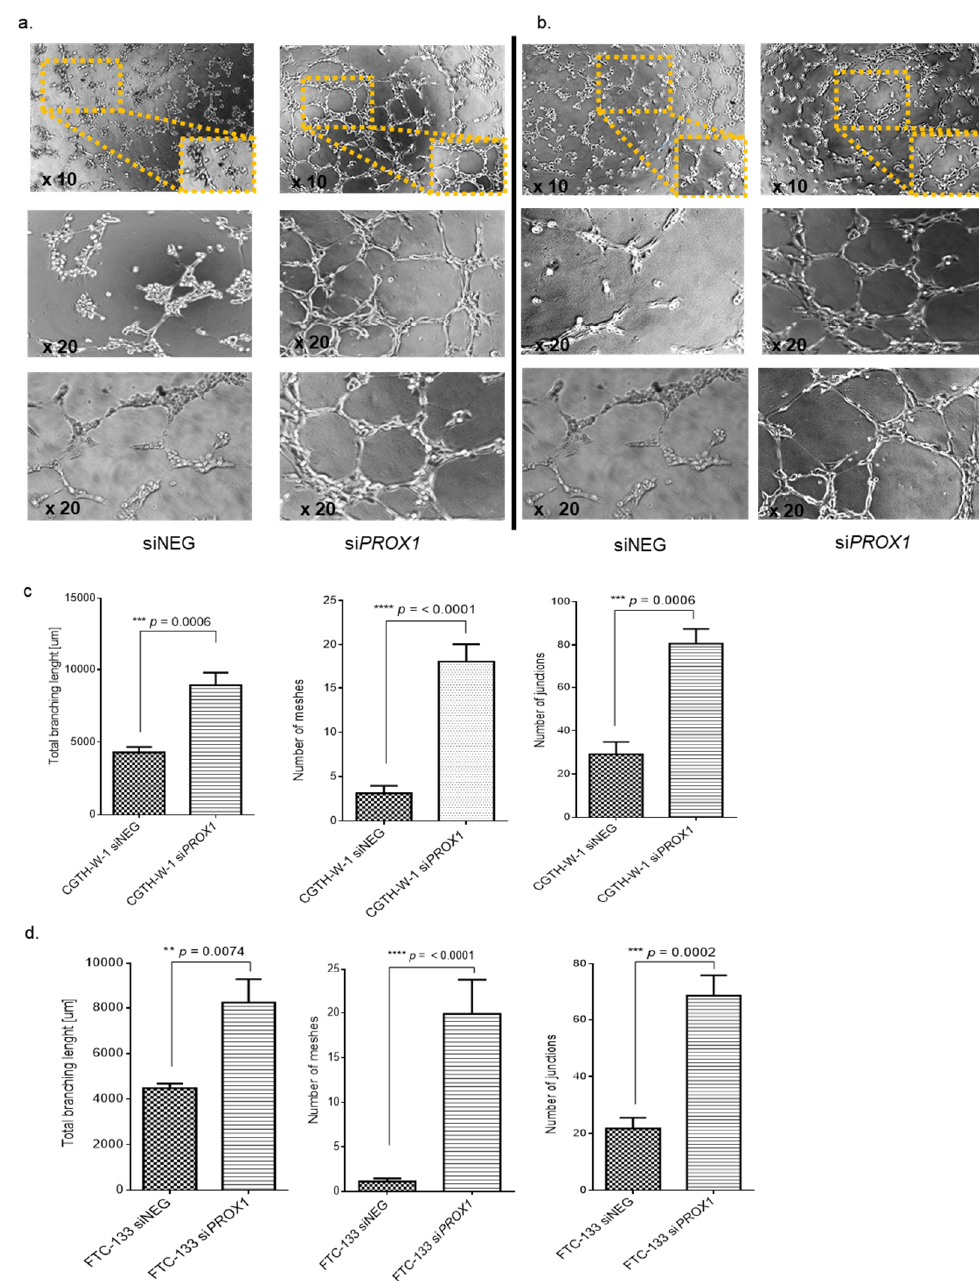
Figure 2. Matrigel tube formation assay. PROX1 silencing in CGTH-W-1 and FTC-133 cells enhances human umbilical vein endothelial cell (HUVEC) angiogenesis in vitro. HUVECs were cultured in 96-well plates coated with a semi-solid Matrigel. The cells were cultured in medium collected from ( a ) CGTH-W-1 and ( b ) FTC-133 cells after silencing of PROX1 and control cells treated with siNEG. The ability of HUVEC cells to form capillary-like structures on Matrigel was assessed under a light microscope after 5 h incubation; original magnifications: × 10 and × 20 lenses. The representative pictures were taken from silencing with si PROX1 (SA). ( c , d ) Total branching, meshes, and junctions were quantified using Angiogenesis Analyzer (ImageJ) and the values were significantly di ff erent between HUVEC cultured in siPROX1-medium compared to cells cultured in siNEG-medium collected from both CGTH-W-1 and FTC-133 cells. The presented graphs show the average values obtained from the experiments performed using two si PROX1 (SA and